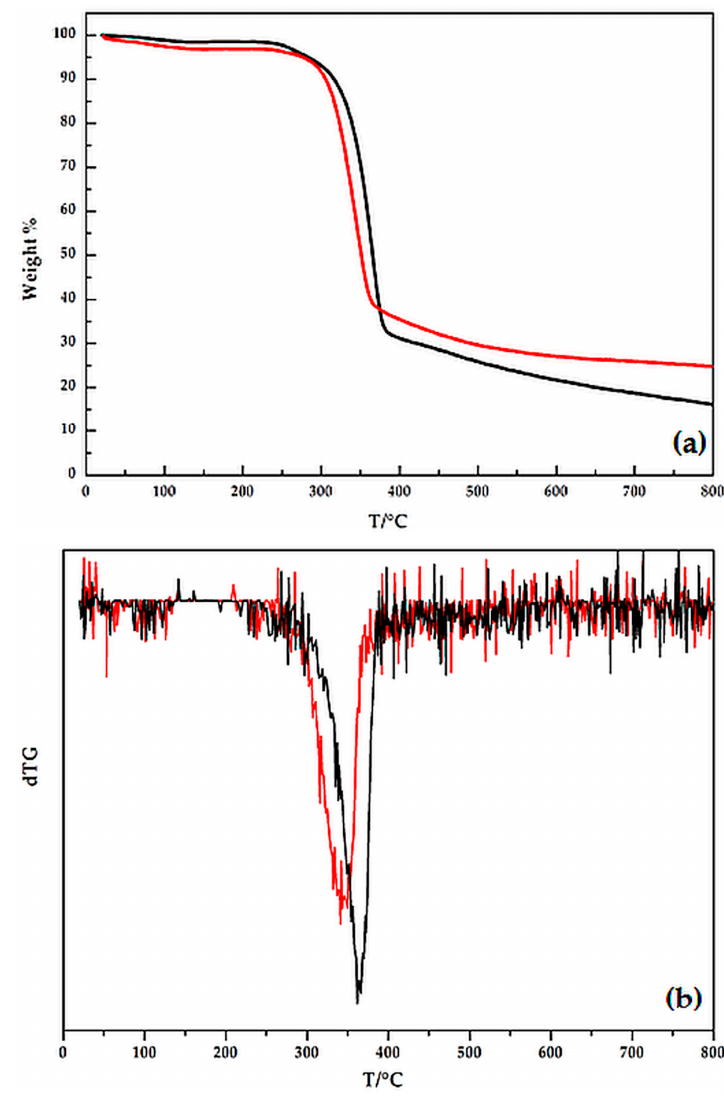
Figure 6. Thermogravimetry (TG) ( a ) and dTG ( b ) curves in an inert atmosphere for hemp, before (black line) and after (red line) the waterglass treatment. Table 2. Thermogravimetry (TG) data obtained in an inert atmosphere.